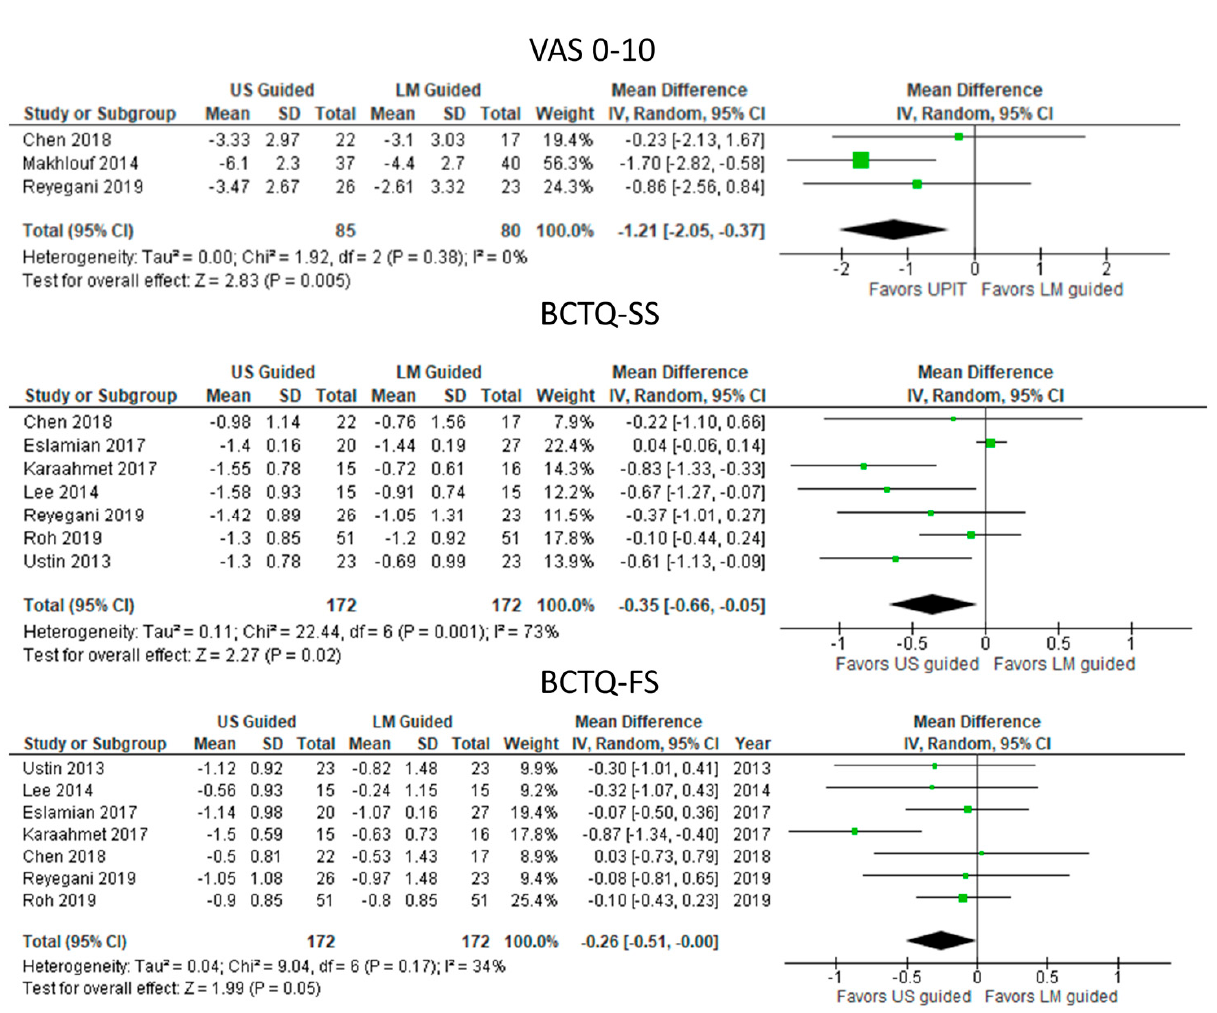
Figure 2. Meta—analysis of UPIT with steroids vs. landmark-guided steroid injection. US, ultra- sound; LM, landmark; VAS, visual analogue scale; BCTQ—SS, Boston Carpal Tunnel Questionnaire—symptom scale; BCTQ—FS, Boston Carpal Tunnel Questionnaire—functional scale. The green squares represent the differences between the means of each of the two groups compared, i.e., the mean differences. The size of the green square represents how much that individual study affects the overall outcome of the meta—analysis, i.e., the weight of the studies on the meta—analysis. The precision of the study depends on the 95% confidence interval for that mean difference, i.e., the length of the straight lines, the shorter the lines, the more precise the mean differences. The black trapezoid is the pooled mean difference of all the studies combined in consideration of the weight of each study, with its confidence interval extending from the left tip to the right